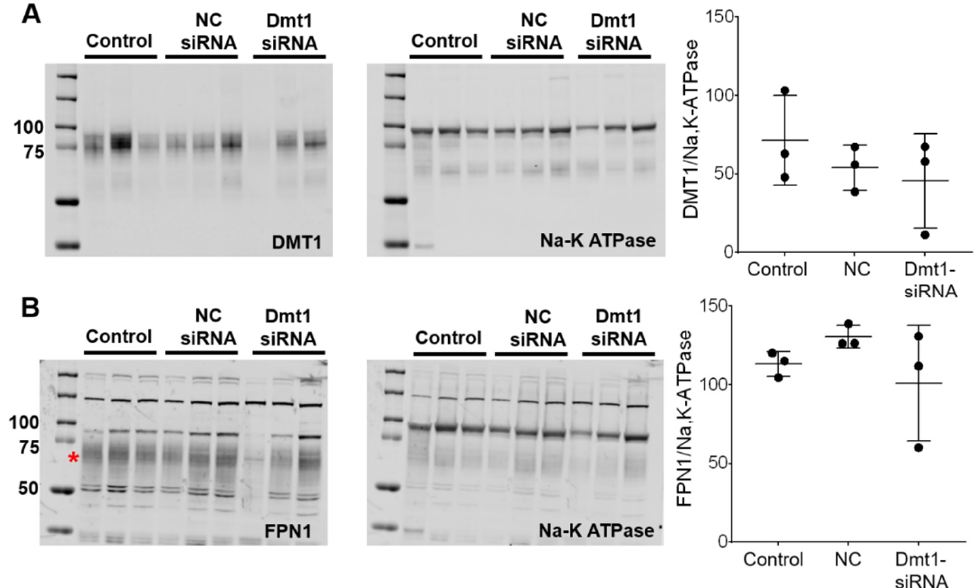
Figure 6. DMT1 and FPN1 protein expression in the duodenal epithelium was unaffected by experimental treatments. Total membrane proteins were isolated from duodenal enterocytes, and equal quantities were run on gels and transferred to membranes. Anti-DMT1 and -FPN1 antibodies were used to detect proteins on the membranes. A Na-K ATPase antibody was used as a control. DMT1 ( A ) and FPN1 ( B ) protein levels were analyzed and normalized by Na-K ATPase protein levels. Quantitative data are mean ± SD for n = 3 mice per group and were analyzed by one-way ANOVA (no statistical differences were noted). The asterisk demarcates the full length immunoreactive Fpn1 band ( B ). To aide in interpretation, the entire blots are shown ( A , B ). NC, negative control.